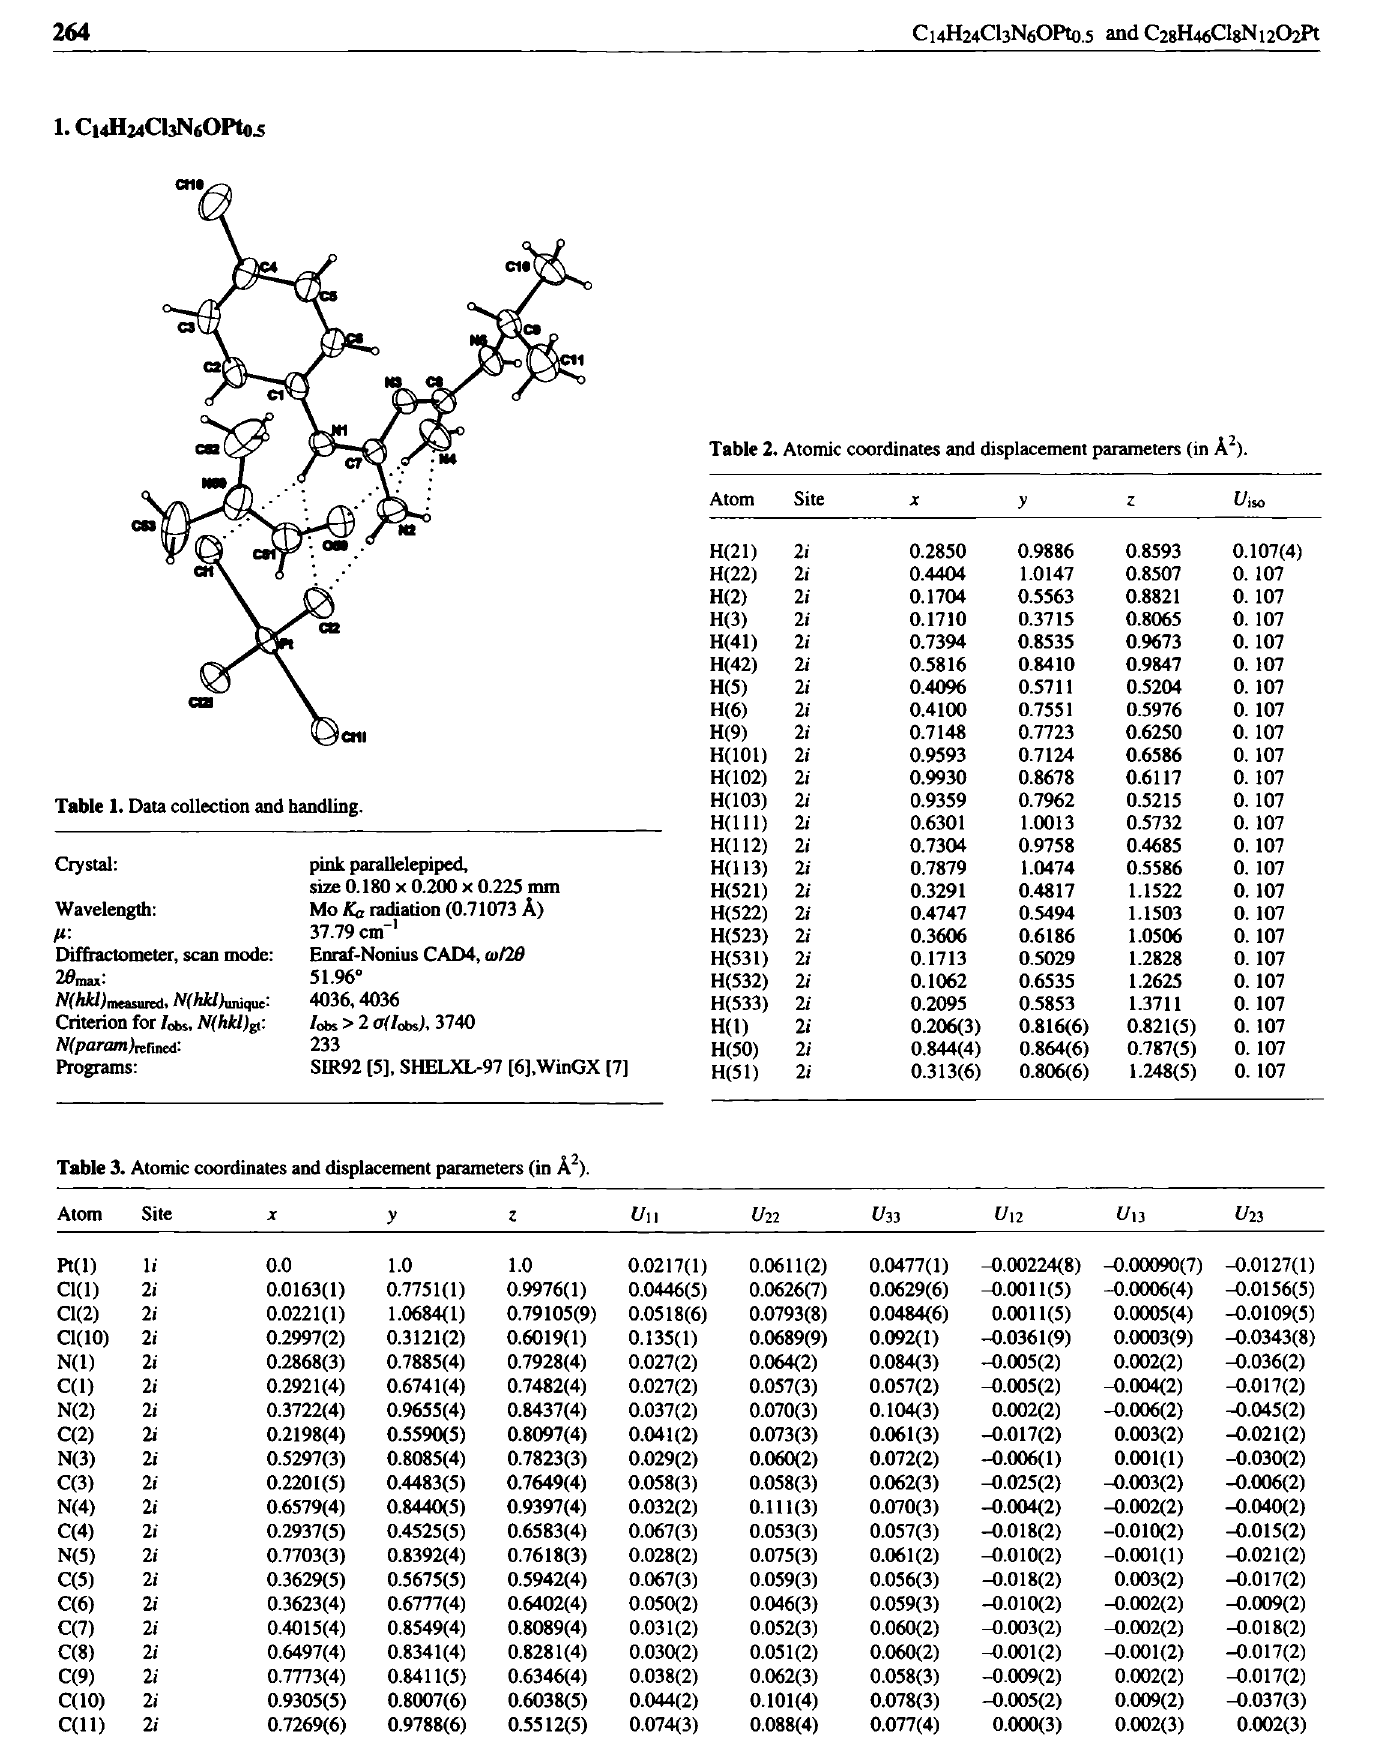
Table 3. Atomic coordinates and displacement parameters (in Â 2 ).